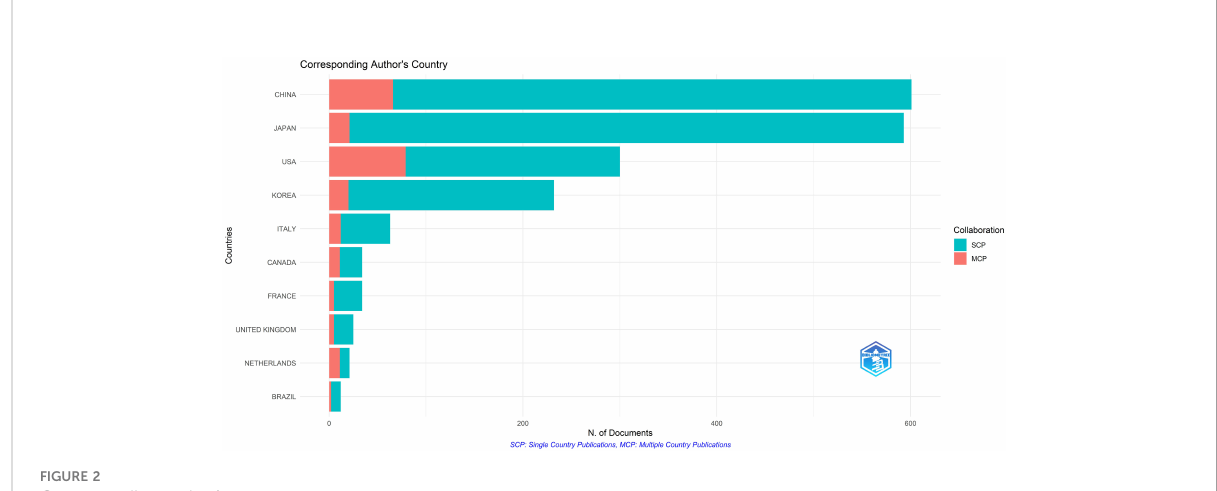
FIGURE 2 Corresponding author ’ s